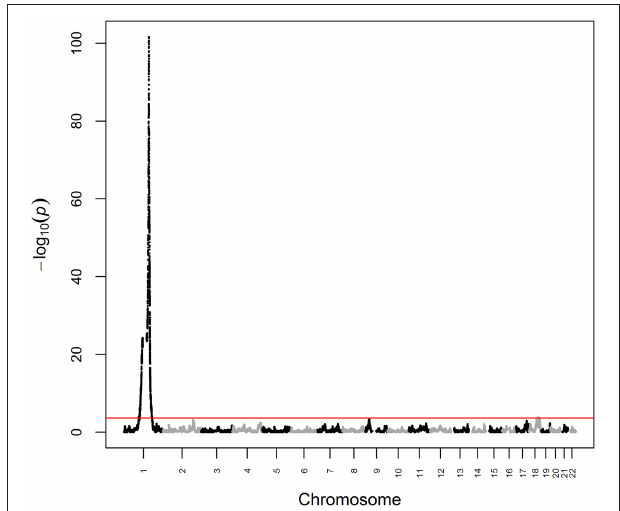
FIGURE 1 | Manhattan plot from admixture mapping for white blood cell count in ARIC. White blood cell count was regressed on local ancestry, adjusted for age, global ancestry, sex, and center. The red line indicates the genome-wide significance level.